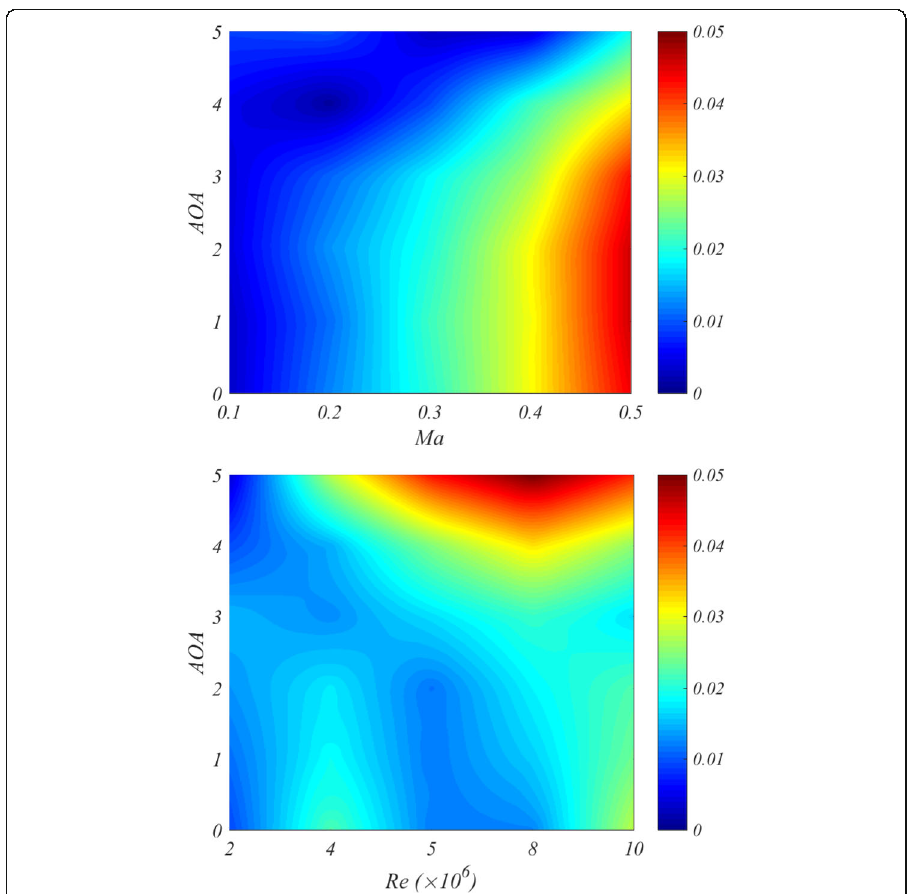
Fig. 13 The relative error contour of C d of the test